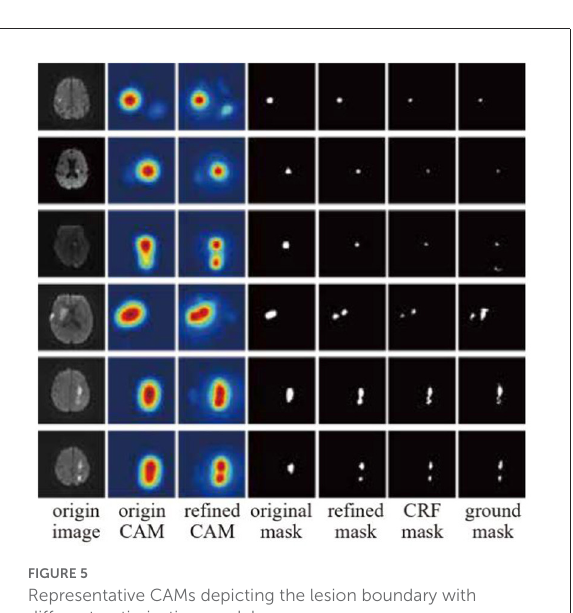
FIGURE5 Representative CAMs depicting the lesion boundary with different optimization